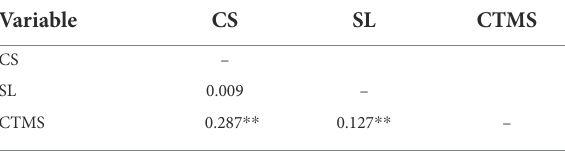
TABLE 3 Correlation Between COVID-19 stress, satisfaction with life, COVID-19 transmission misinformation. Variable CS SL